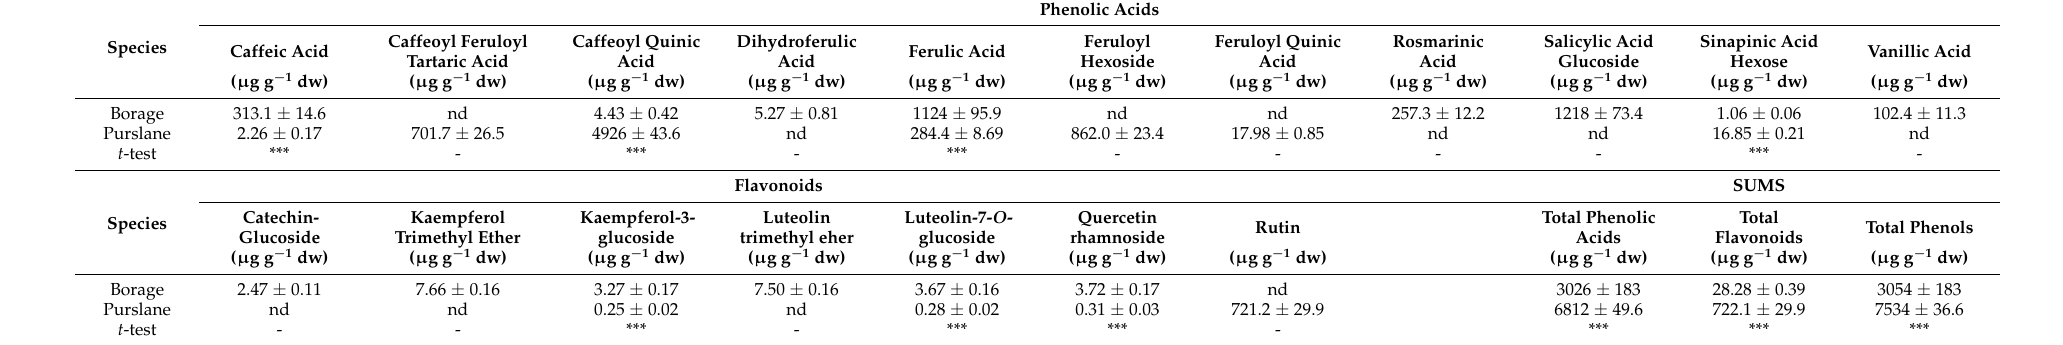
Table 5. Phenolic profiles and phenolic acids and flavonoid composition of the microgreen species grown in controlled conditions. Means were statistically separated using a two-tailed Student’s t -test. ***: p < 0.001; nd: Not